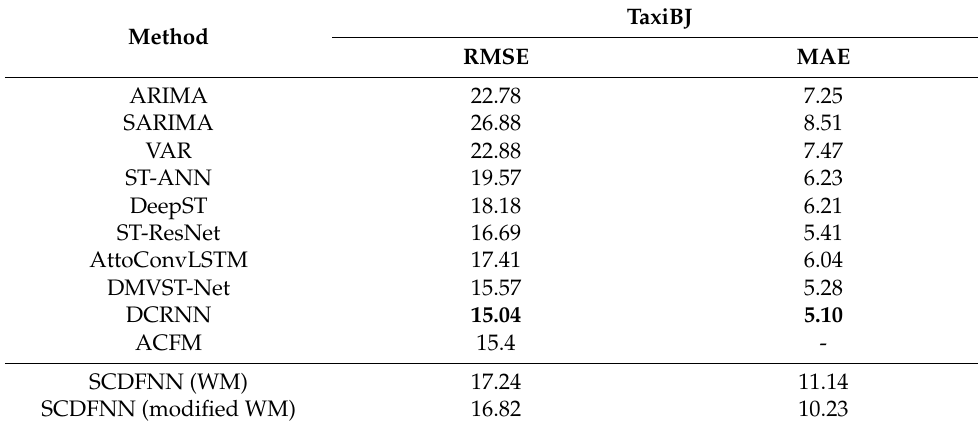
Table 4. Comparison results of different methods on TaxiBJ datasets.